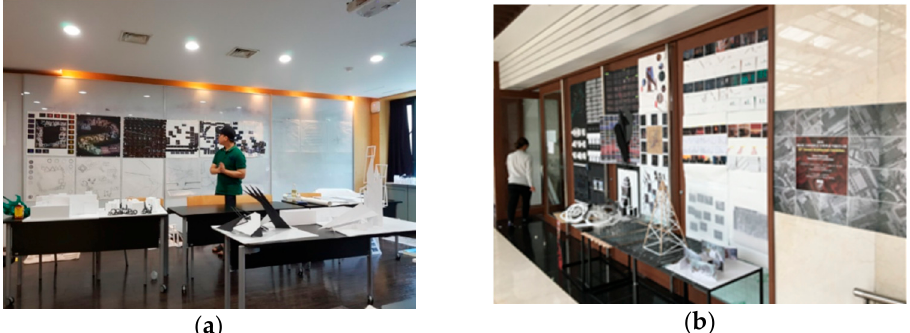
Figure 7. Final jury and exhibition of student work: ( a ) a student presented his work in front of jury members and ( b ) the view of the end-of-semester exhibition.